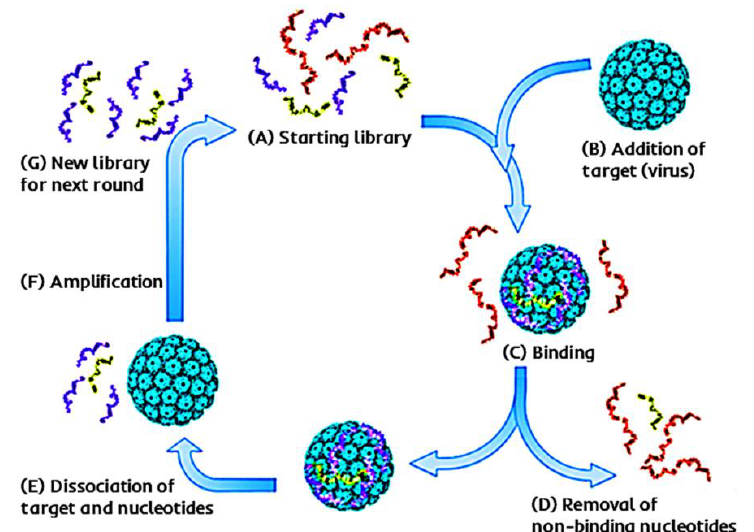
Figure 8. A schematic representation of the SELEX process for producing aptamers: ( A ) The process starts with a library containing nucleotides with varying length and sequences; ( B ) The target molecule (in this example a virus particle) is added and favorable conditions are provided for binding. ( C ) Once, the binding between the virus particles and the nucleotides is achieved; ( D ) the non-binding nucleotides are removed; ( E ) The bound nucleotides are subsequently separated from the virus particles, and ( F ) amplified; ( G ) Finally, the product is used as a new library for another cycle. The cycle is repeated (typically 5–20 times) until only strongly binding nucleotides are present.